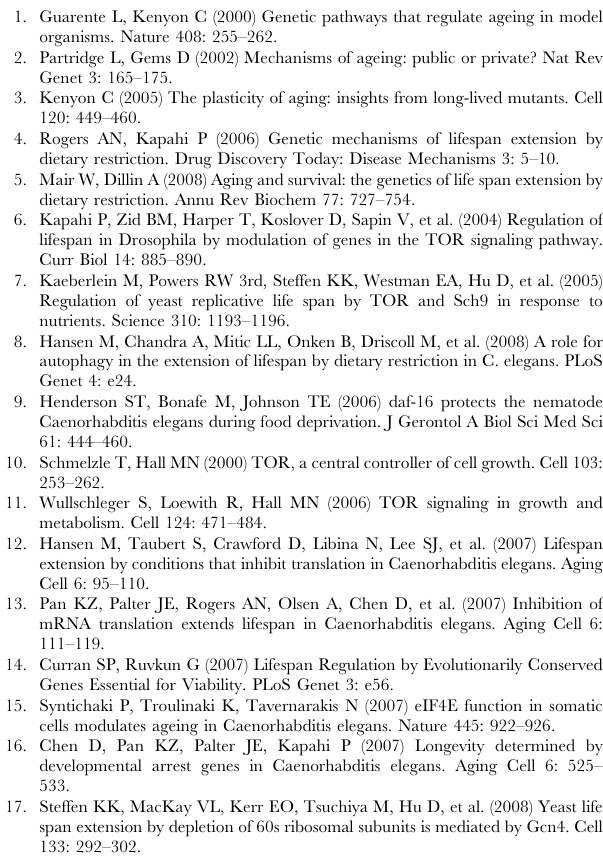
Table S2 HIF-1 and IRE-1 mediate lifespan extension by DR.